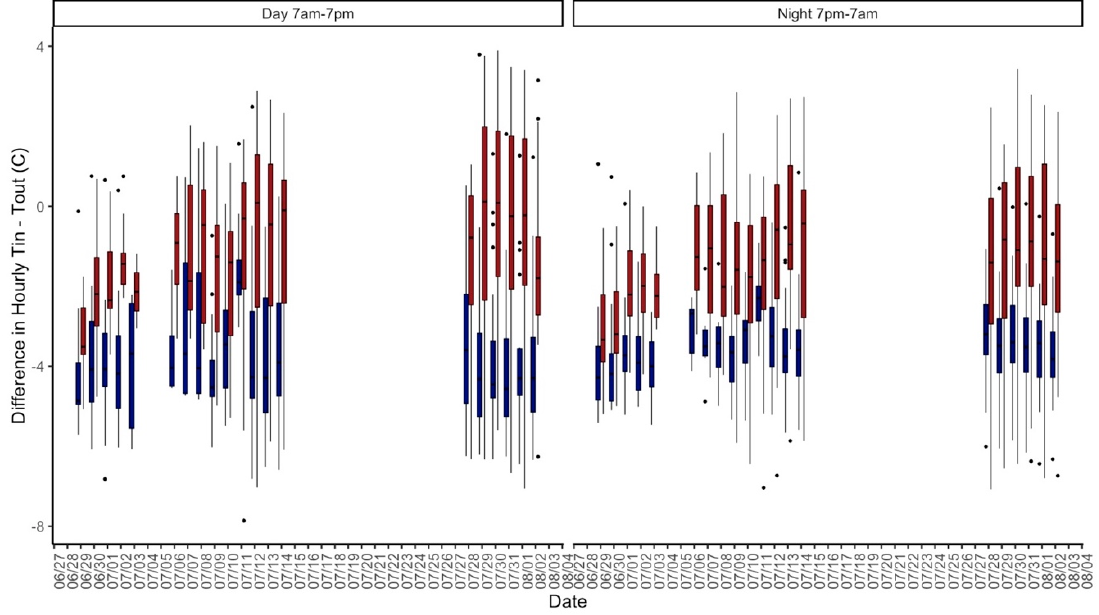
Figure 2. Difference between hourly indoor and outdoor temperatures (boxplots) of non-central AC (red) and central AC (blue) groups during both day (7 am–7 pm) and night (7 pm–7 am) periods.